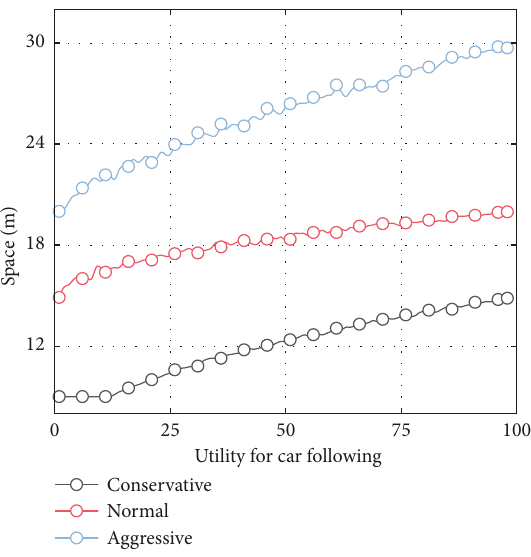
Figure 5: The utility for car-following